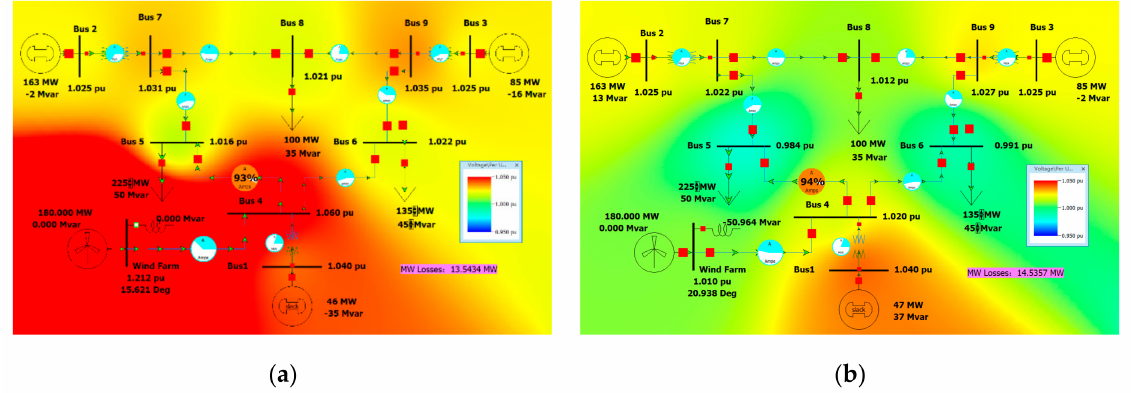
Figure 14. Simulation results of the maximum load of tower C connected to bus 4 (500 km). ( a ) Maximum load condition. ( b ) Maximum load condition with